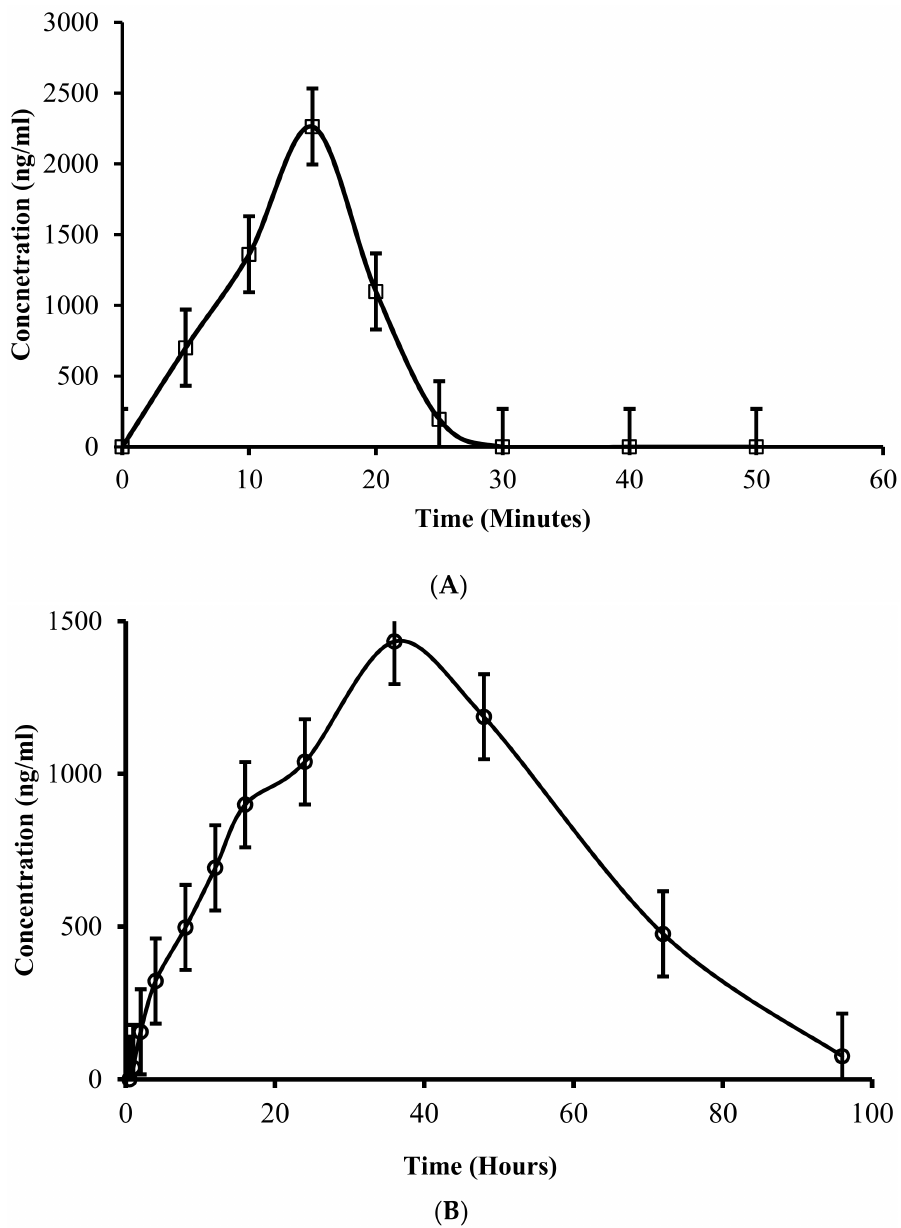
Figure 14. Plasma drug concentration-time plots of 5-FU administered through the subcutaneous route in free pure solution form ( A ) and loaded in depot gel form ( B